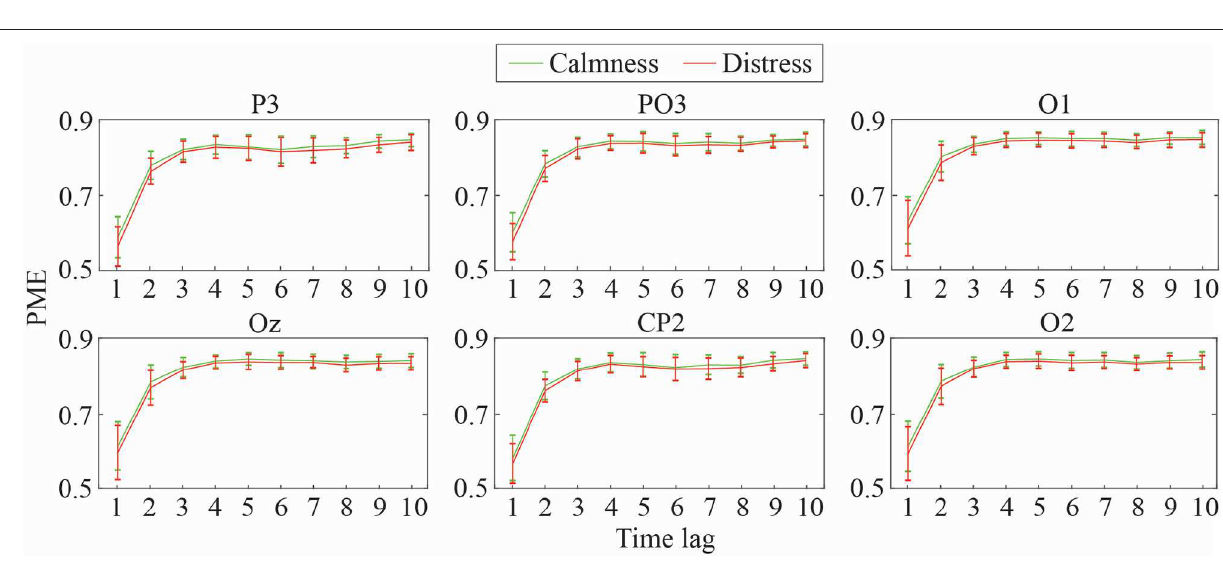
Frontiers in Neuroinformatics |